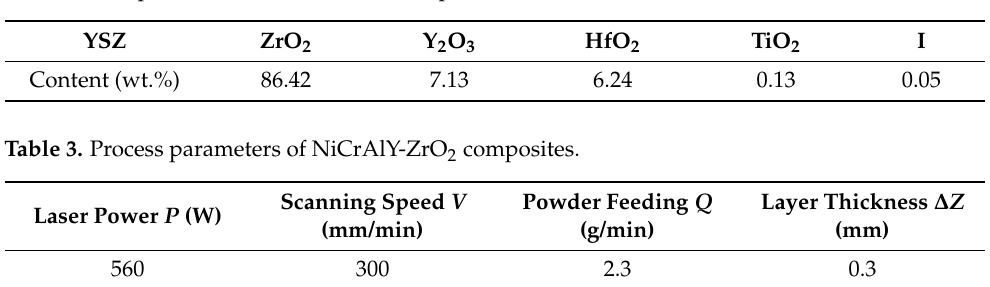
Table 2. Composition and contents of ZrO 2 powders.